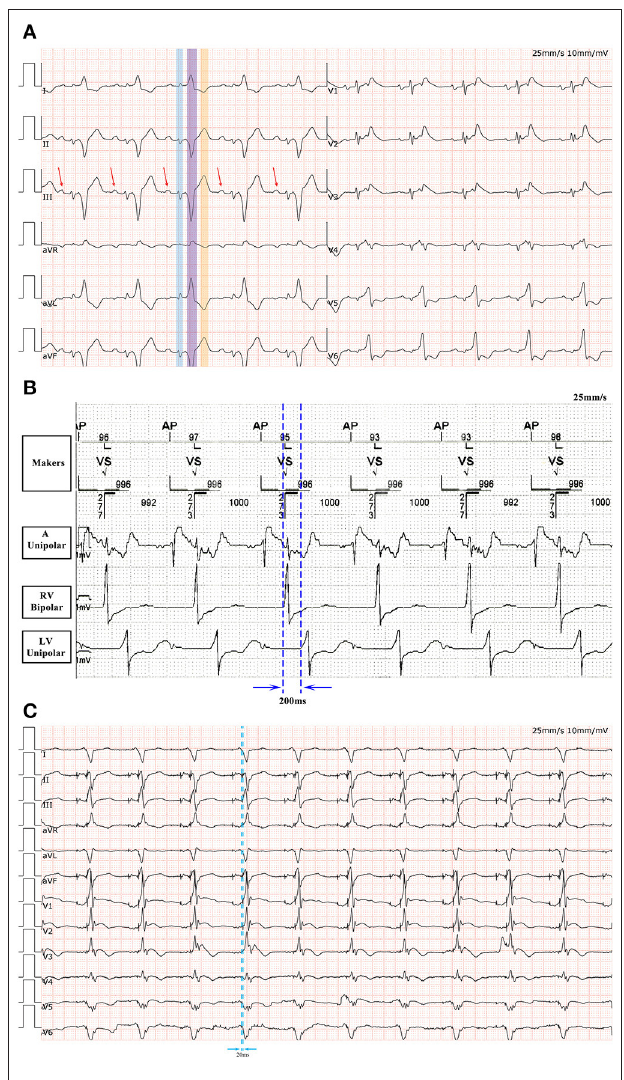
FIGURE 3 | (A) A 12-lead ECG after ablation. The underlying rhythm is sinus rhythm with QRS duration of 360ms. Note the initial QRS complex mimicking atrial electrical activity in standard (highlighted in blue). The real P wave is indicated by the arrow. Another QRS complex in this sequence is highlighted in purple. The wave highlighted in orange is the T wave. (B) The right ventricular-left ventricular interval is 200ms in the absence of ventricular pacing. (C) Following ECG optimization by CRT-P programming, the QRS complex is significantly